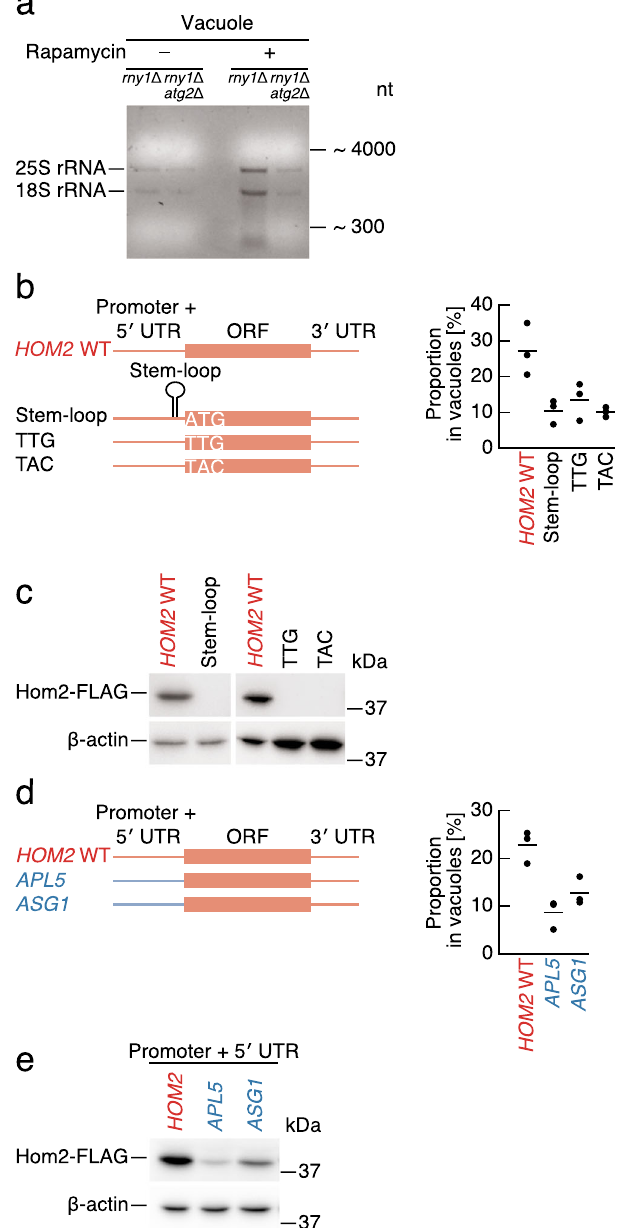
Fig. 3 Autophagy-mediated mRNA degradation is coupled with translation. a Autophagy-dependent rRNA accumulation in the puri fi ed vacuole fraction. Agarose gel electrophoresis of RNAs from puri fi ed vacuoles with or without 3 h rapamycin treatment. Representative results from three independent experiments are shown. b, d Proportion of a representative vacuole-enriched reporter mRNA , HOM2 , recovered from vacuolar fractions following 3 h rapamycin treatment. Data were analyzed as described in Fig. 2d. In b , translation was blocked either through the introduction of an inhibitory stem-loop just before the HOM2 start codon, or by introducing point mutations into the start codon (ATG to TTG or TAC). In d , the promoter-5 ′ UTR region of HOM2 was replaced with that of vacuole-depleted APL5 or ASG1 . Data present mean (line) and individual results (points) of three independent experiments. c, e Protein levels of reporter mRNAs used in b and d as determined by Western blotting in growing condition. Representative results from two independent experiments are